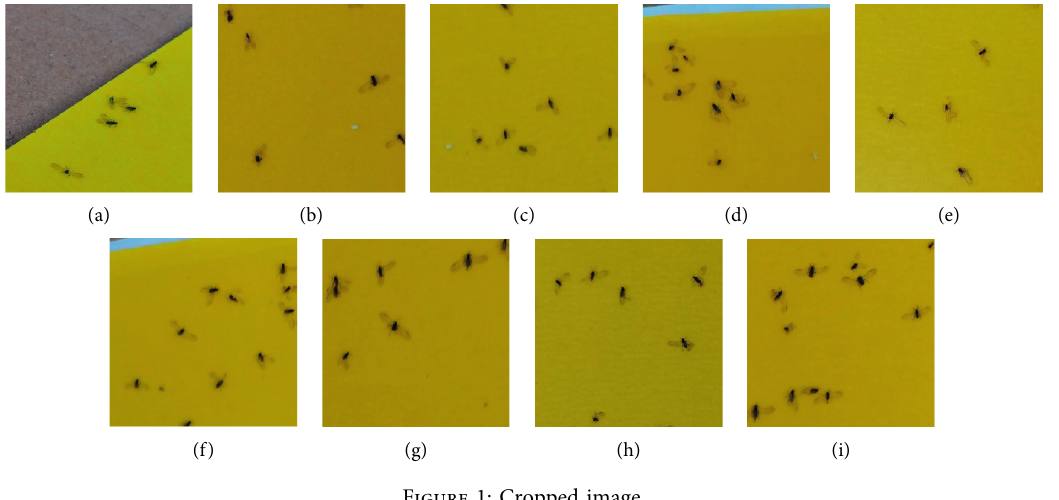
Figure 1: Cropped image.